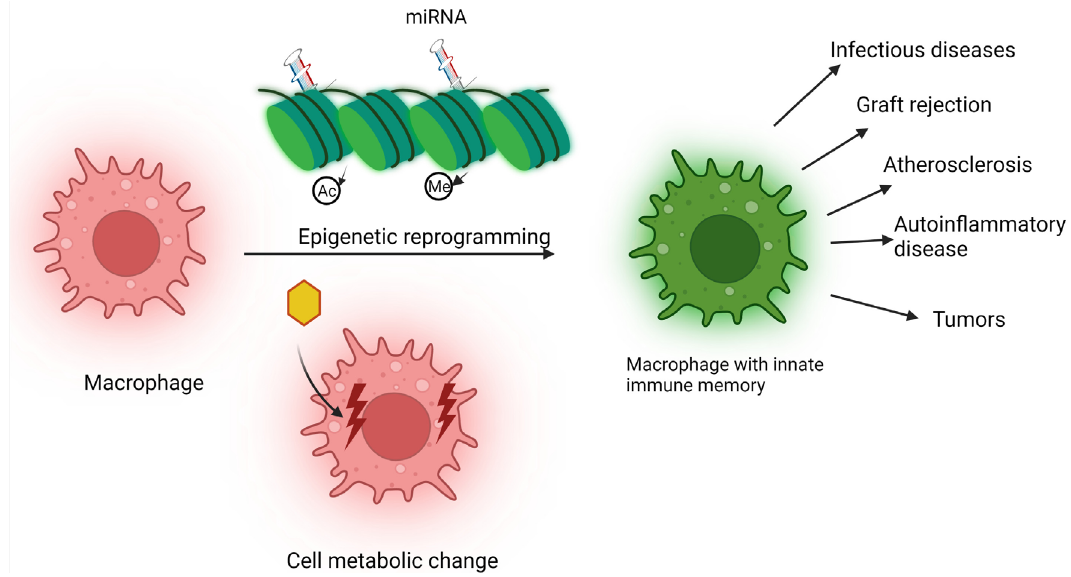
Figure 2. IIM of macrophages The